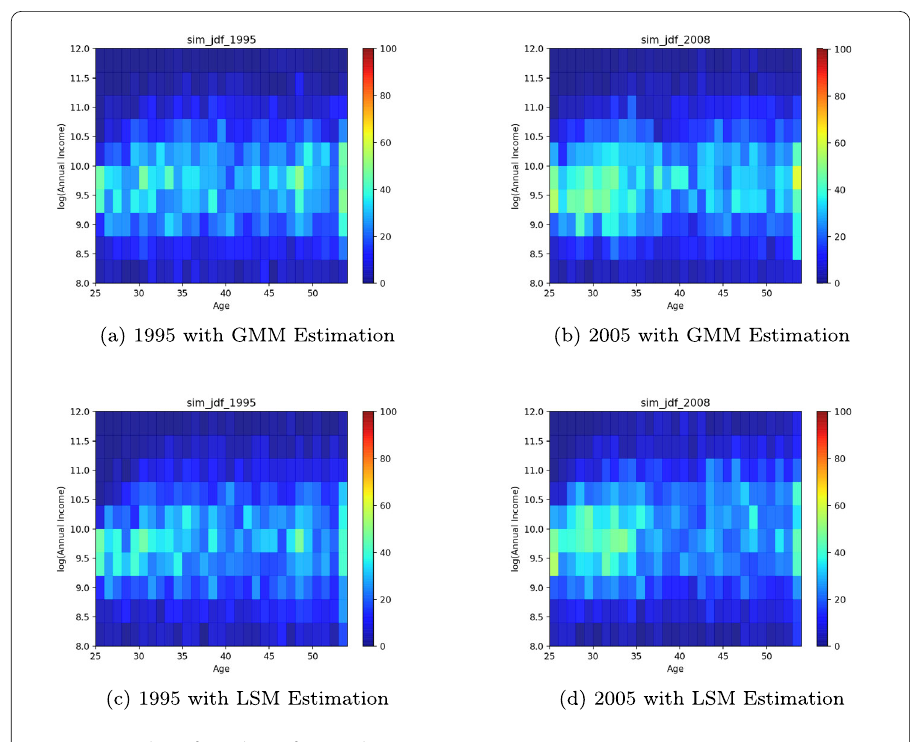
Figure 7 JDF Plots of Simulation for UK Labour